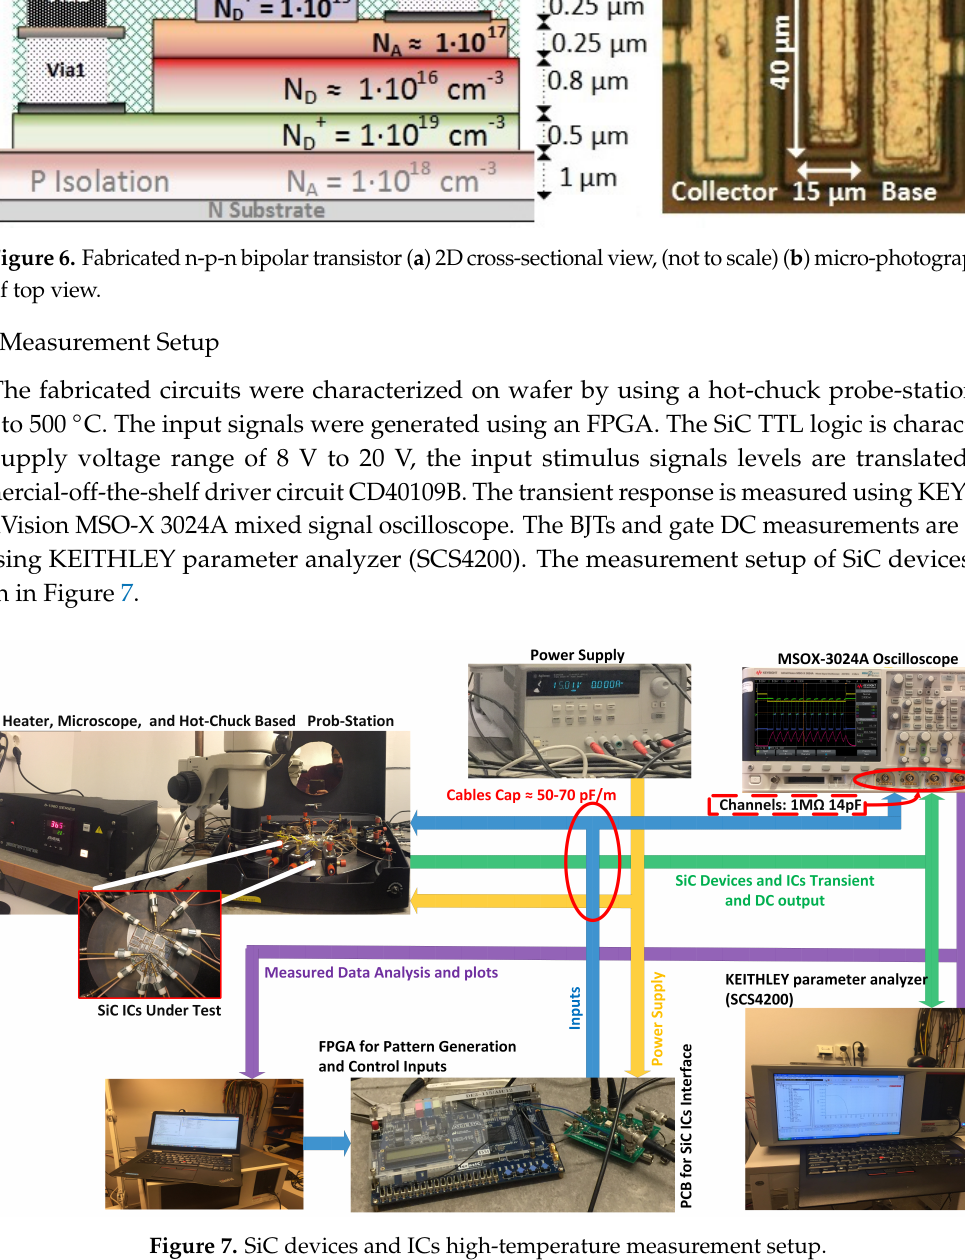
Figure 7. SiC devices and ICs high-temperature measurement